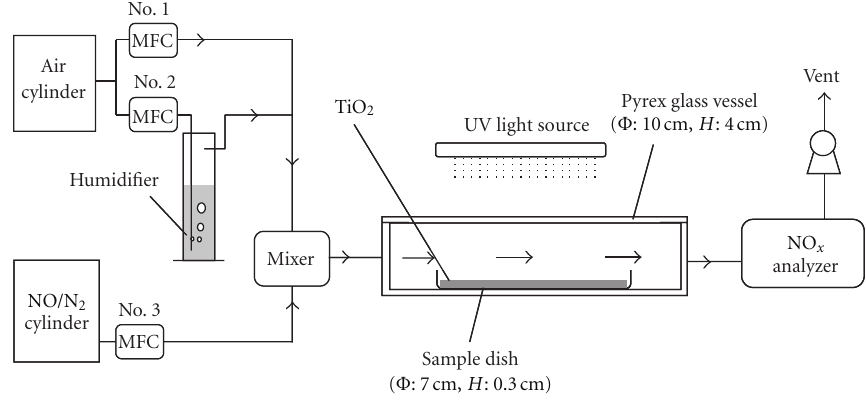
Figure 1: Schematic continuous flow reaction system for photocatalytic degradation of